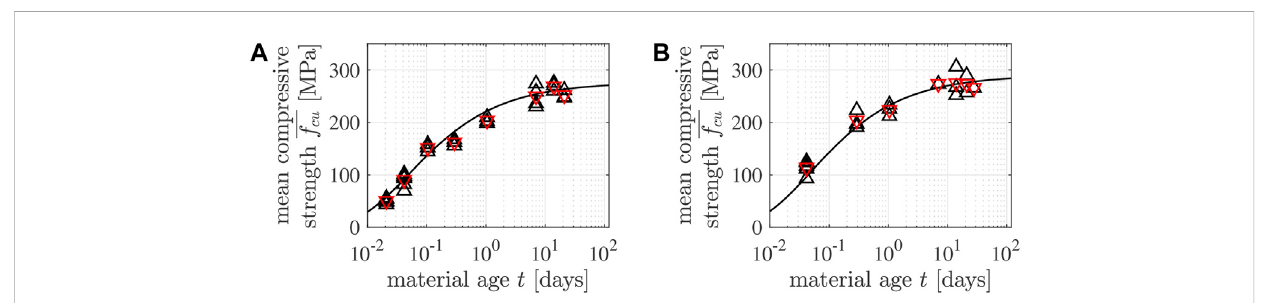
FIGURE 7 Early-agestrengthevolutionof (A) the5/10specimensand (B) the4/6specimens:theblack △ symbolsmarkindividualstrengthvaluesofTables4,5, the red ▽ symbols mark the corresponding mean values of Table 6, and the black solid lines were obtained from the combination of Eqs 6 – 9.